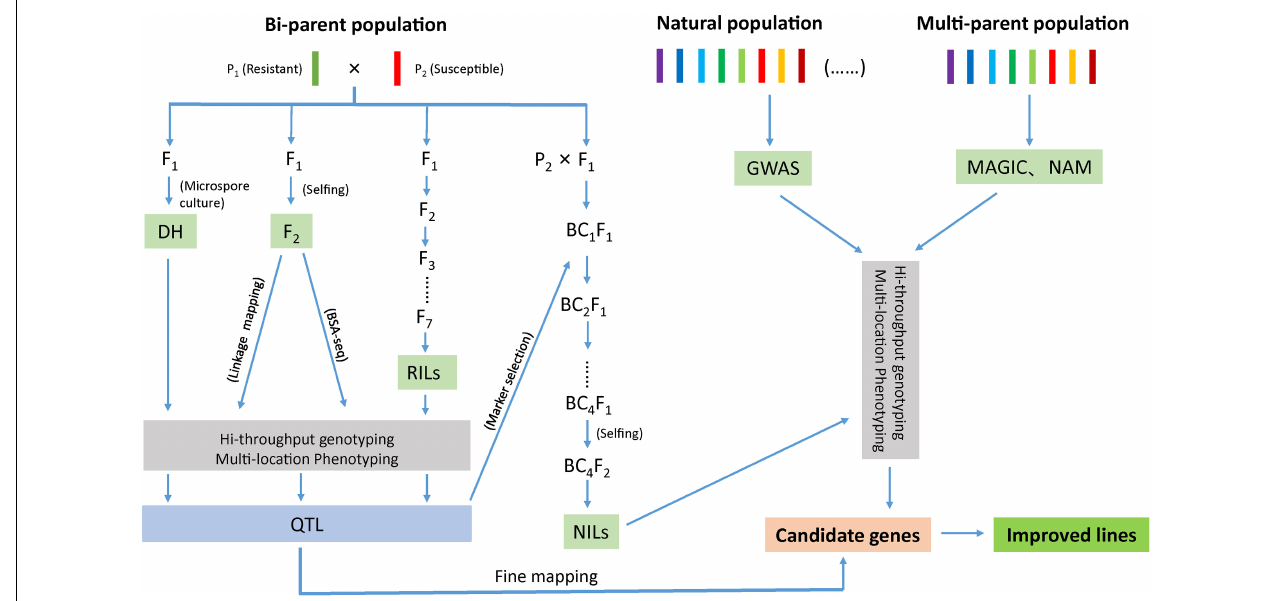
FIGURE 1 | Schematic diagram representing different approaches to develop improved lines for disease